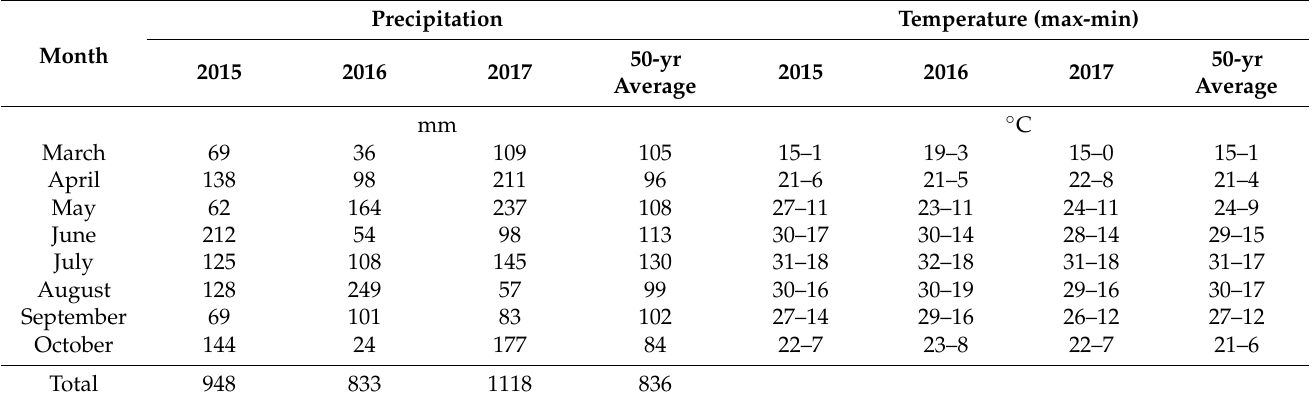
Table 2. Growing season rainfall and temperature at foliar N study sites in Surry Co. NC